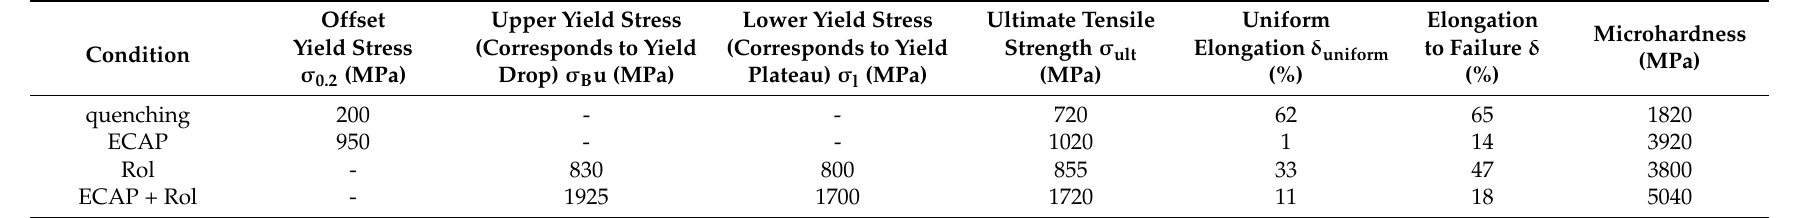
Table 2. Mechanical properties of the steel after different types of